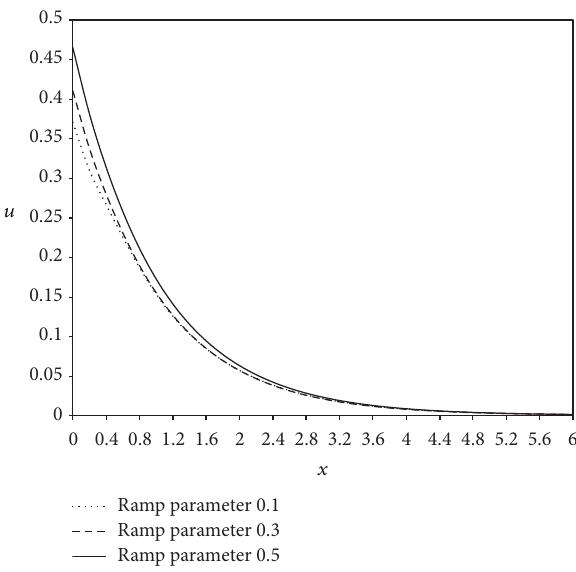
Figure 9: Stress distribution 𝜎 for different values of ramp parame- ter at 𝛼 = 0.5 , 𝑡 = 0.1